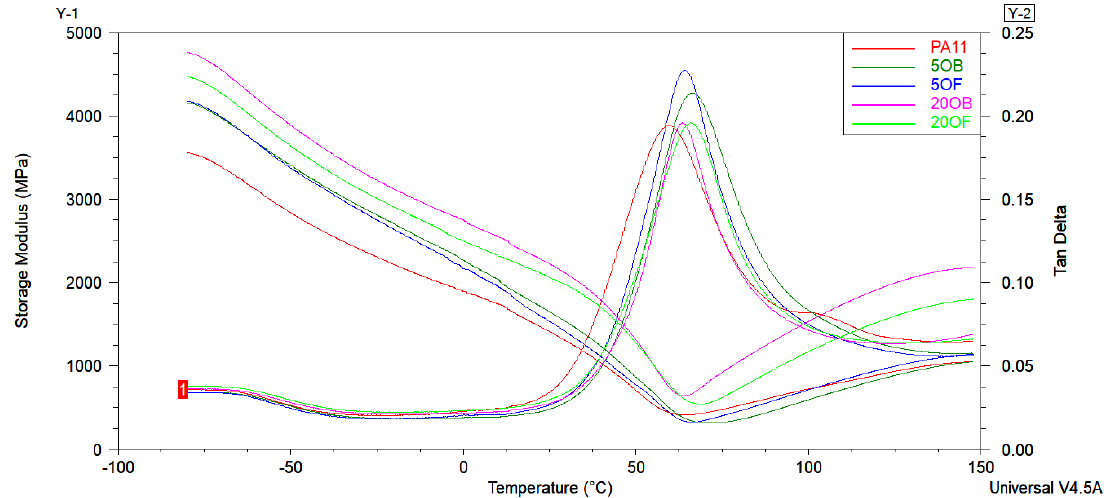
Figure 16. The results of the storage modulus and tan δ of PA11/diatoms biocomposi tes. Table 7. Summary of the determined values of the glass transition temperature from storage modulus E’ curves.